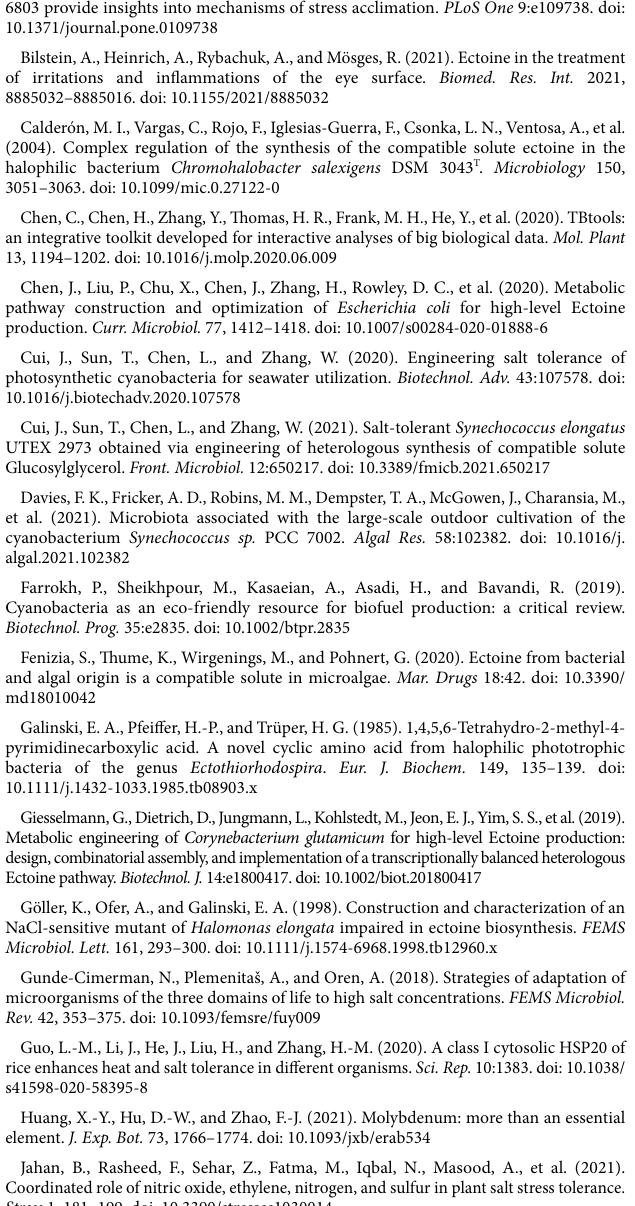
SUPPLEMENTARY FIGURE S1 Growth curves of WT, Syn7942/NSI-ect, Syn7942/ Δ sps, and Syn7942/ Δ sps- ect. (A) Growth curves of WT under 0, 100, 200, 300, 400, 500 mM NaCl; (B) Growth curves of Syn7942/NSI-ect under 0, 100, 200, 300, 400, 500 mM NaCl; (C) Growth curves of, Syn7942/ Δ sps under 0, 100, 200, 300, 400, 500 mM NaCl; (D) Growth curves of, Syn7942/-sps-ect under 0, 100, 200, 300, 400, 500 mM NaCl. SUPPLEMENTARY FIGURE S2 Standard curve of ectoine external standard method.